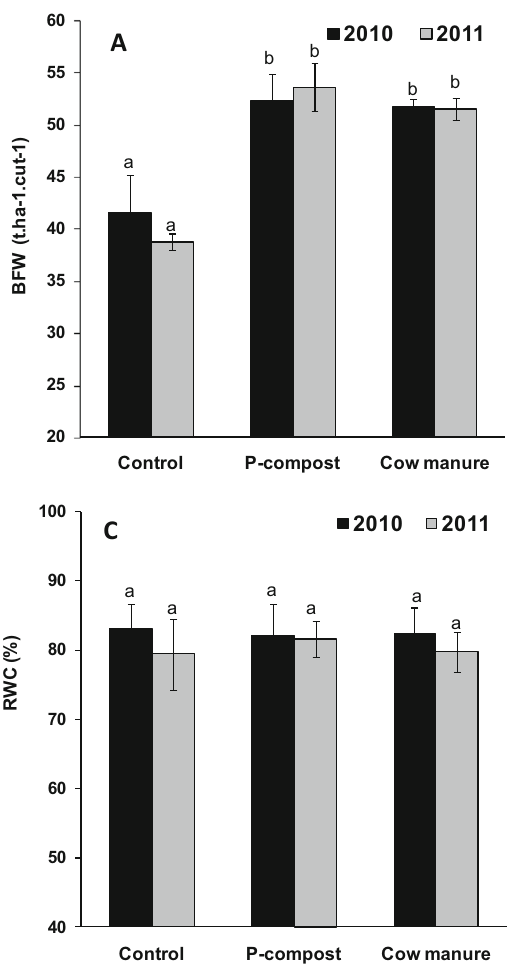
seasons of alfalfa. Values with different letters are statistically according to a Dunnett’s test at P =